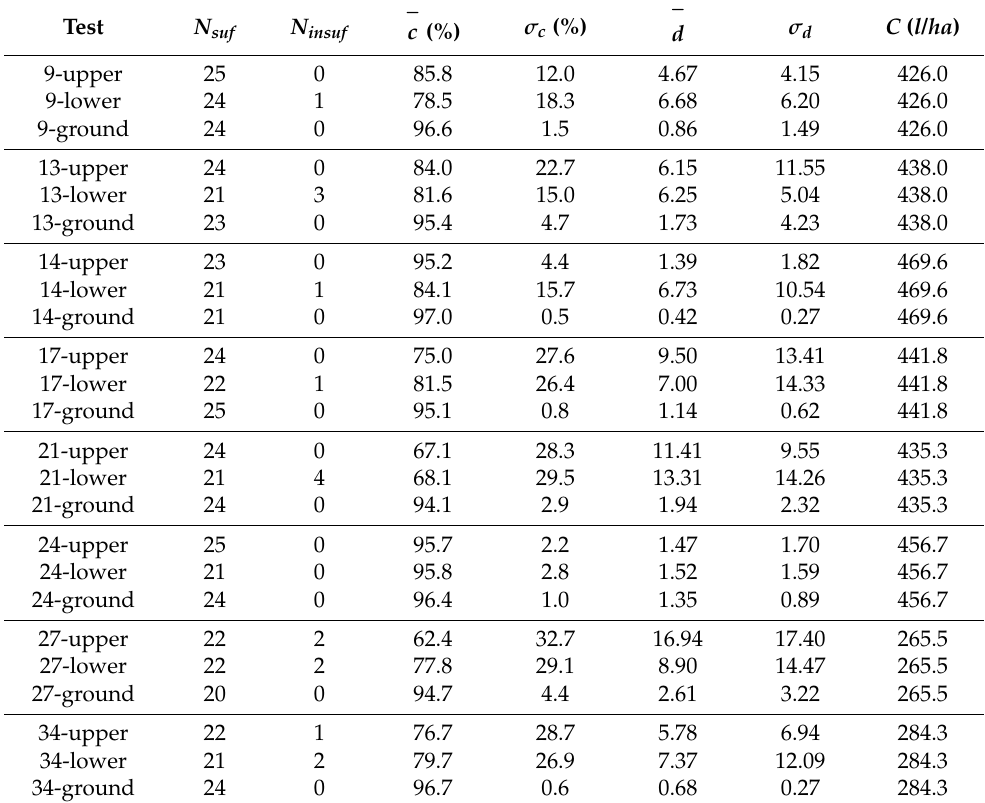
Table 1. The selected results from the first (nos. 9, 13, 14) and the second test session (nos. 17, 21, 24, 27,